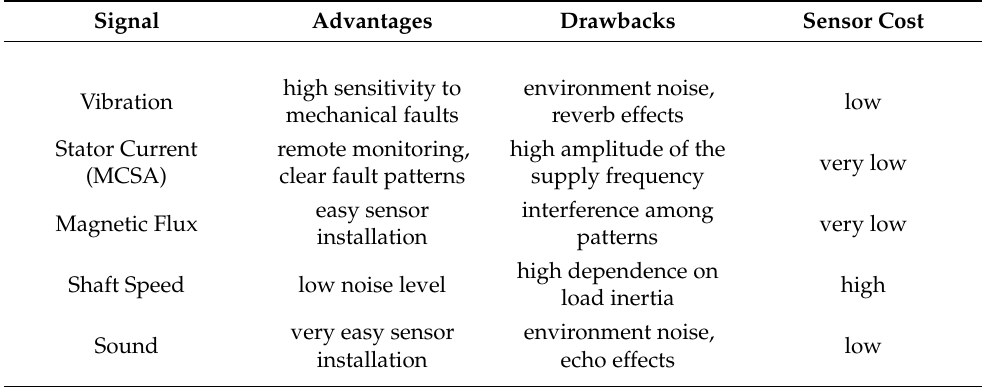
Table 1. Main advantages and drawbacks of common monitoring physical